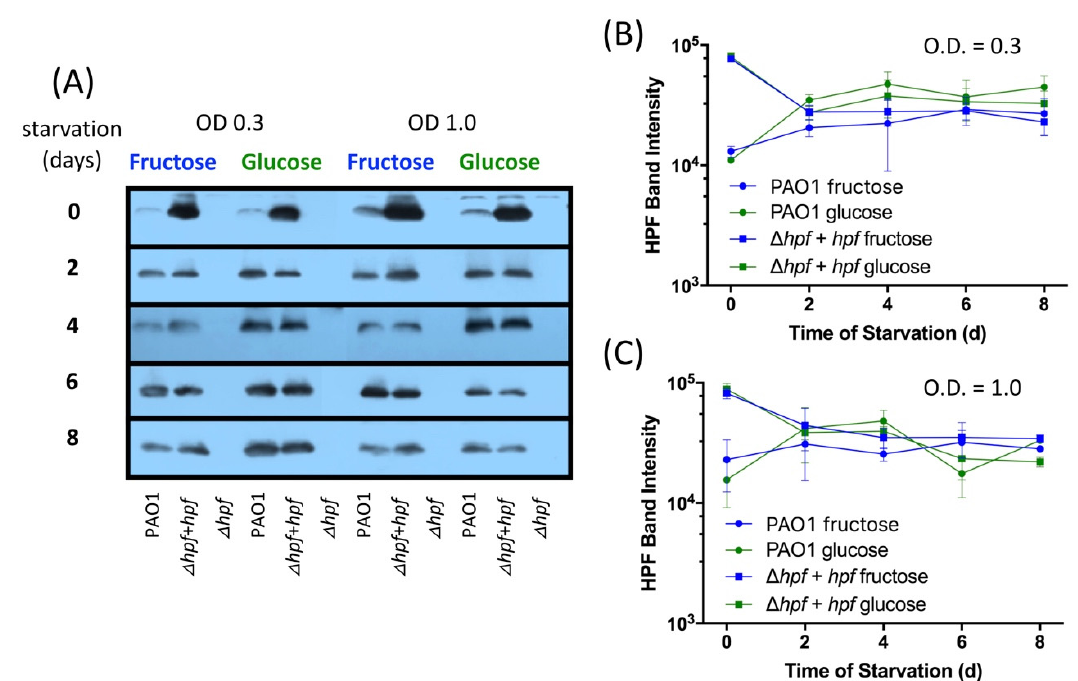
Figure 7. Effect of nutrient source and pre-growth conditions on cellular HPF abundances. ( A ) Immunoblots of HPF over 8 d of starvation for strains P. aeruginosa PAO1, ∆ hpf , ∆ hpf + hpf , pre-cultured in minimal medium with glucose or fructose to early exponential phase O.D. 600 = 0.3 or O.D. 600 = 1.0. ( B ) Mean and standard error of the mean for immunoblot HPF band intensities for PAO1 and ∆ hpf + hpf strains pre-cultured in minimal medium to O.D. 600 = 0.3. (Results from ∆ hpf strain were below detection). ( C ) Mean and standard error of the mean for immunoblot HPF band intensities for PAO1 and ∆ hpf + hpf strains pre-cultured in minimal medium to O.D. 600 = 1.0.